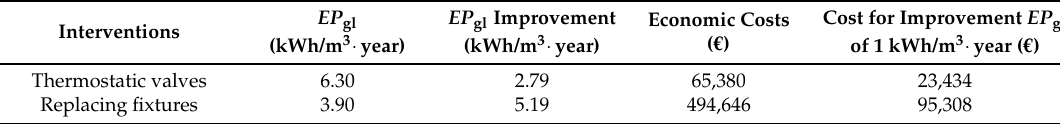
Table 12. Economic costs and EP gl improvement for each considered intervention in MiSE.